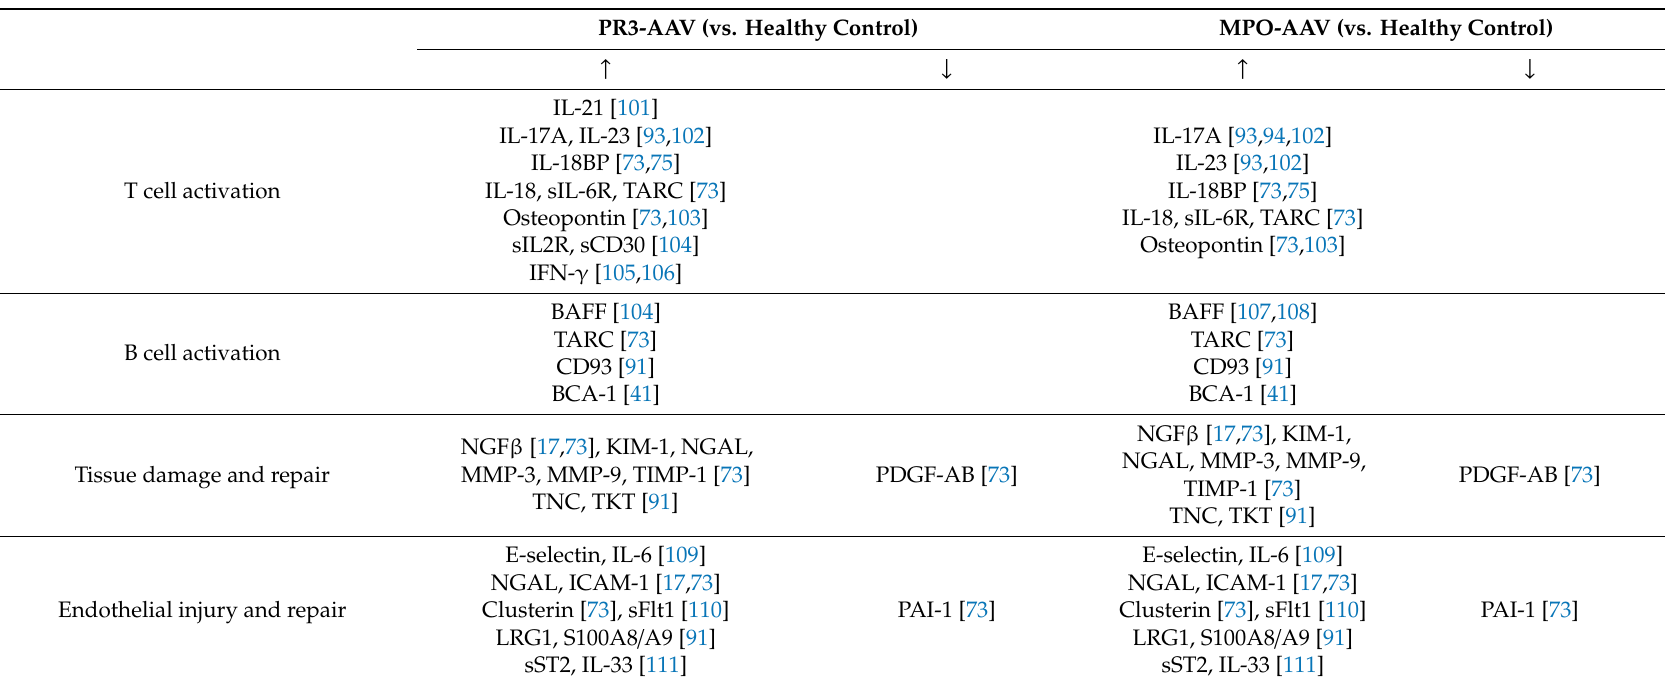
PR3-AAV (vs. Healthy Control) MPO-AAV (vs. Healthy